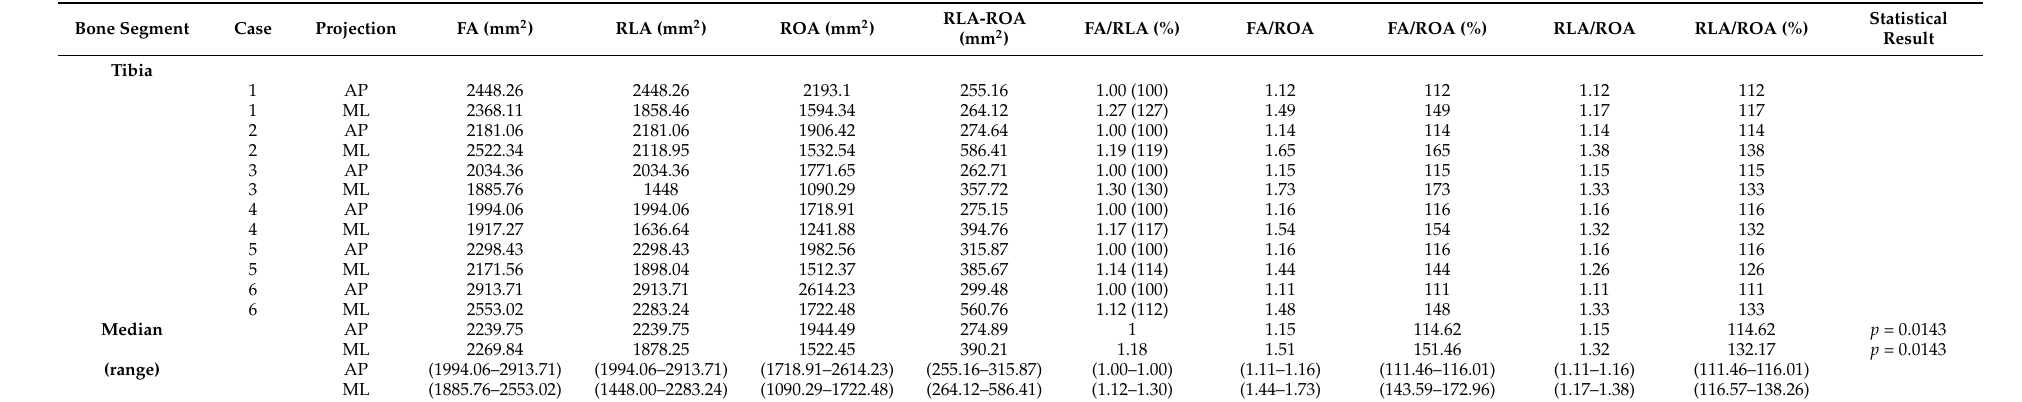
Table 3. Measurements of the tibia in the antero-posterior and medio-lateral